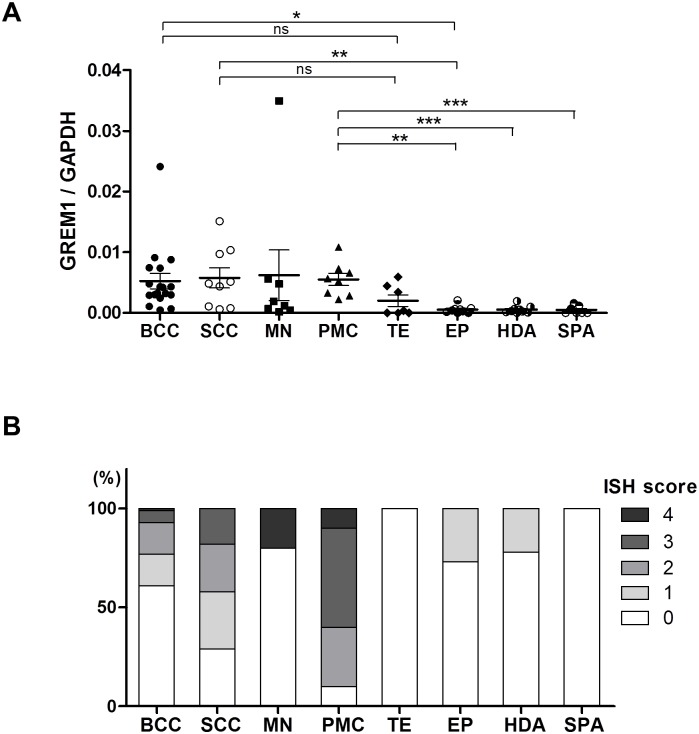
mRNA levels of GREM1 in various skin tumors.(A) Real-time PCR analysis was performed to examine the expression of GREM1 in a variety of skin tumors, including basal cell carcinomas (BCCs, n = 18), squamous cell carcinomas (SCCs, n = 9), melanomas (MNs, n = 8), pilomatricomas (PMCs, n = 8), trichoepitheliomas (TEs, n = 7), eccrine poromas (EPs, n = 9), hidradenomas (HADs, n = 9), and spiradenomas (SPAs, n = 7). *P < 0.05; **P < 0.00; 5***P < 0.001; ns, not significant. (B) The proportion of RNA in situ hybridization (ISH) scores for GREM1 in skin tumors. Analysis of GREM1 expression by RNA ISH was performed on tissue microarrays, including BCCs (n = 81), SCCs (n = 17), MNs (n = 5), PMCs (n = 10), TEs (n = 16), EPs (n = 11), HDAs (n = 9), and SPAs (n = 10). RNA ISH for GREM1 was scored from 0 to 4, reflecting the intensity of GREM1 expression.